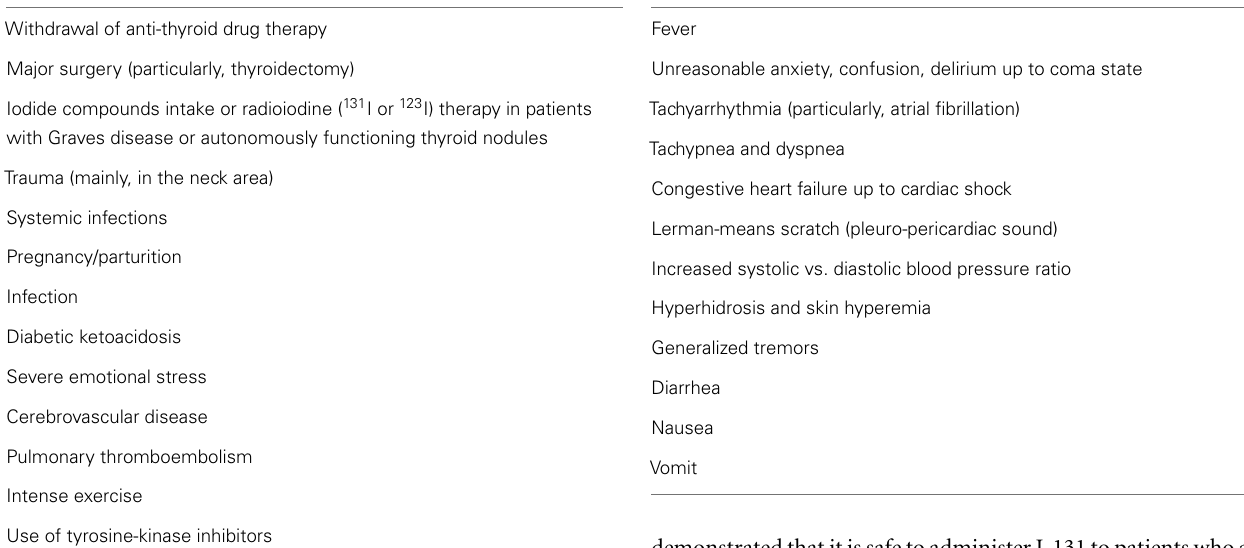
Table 2 | Known triggers of thyrotoxic storm . Table 3 | Symptoms and signs peculiar to thyrotoxic storm